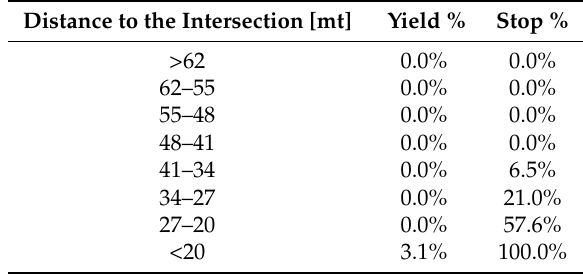
Table 1. Detection rate based on the Viola–Jones